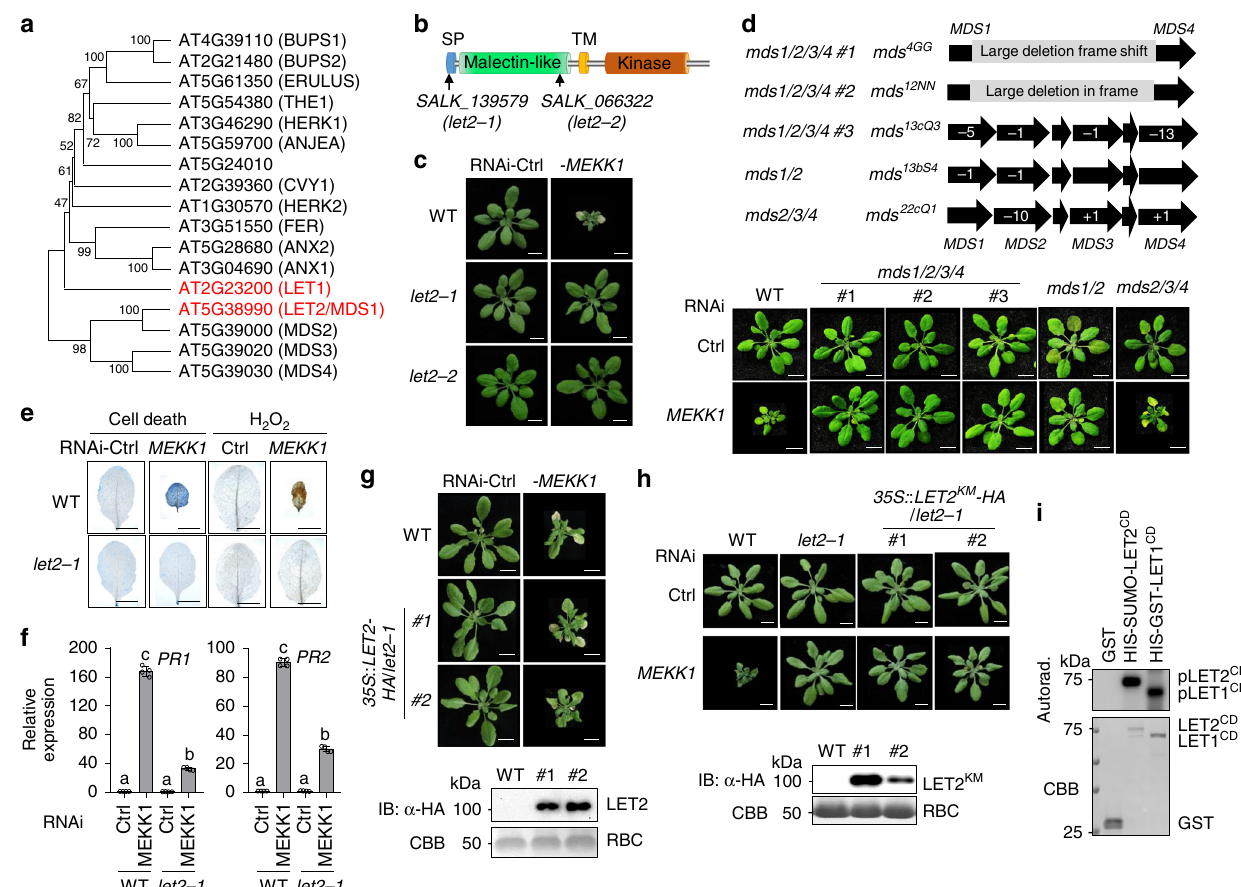
Fig. 1 LET2/MDS1 is involved in RNAi-MEKK1 cell death. a A phylogenetic tree of Cr RLK1L family proteins. The full-length protein sequences were used to generate the phylogenetic tree by the UPGMA method with 1000 bootstrap replicates in MEGA-X. b A schematics depicting LET2/MDS1 protein motifs and T-DNA insertion sites in the let2 mutants. LET2/MDS1 consists of the N-terminal signal peptide (SP), a malectin-like domain, a transmembrane domain (TM), and a cytosolic kinase domain. The arrows indicate the T-DNA insertion sites of the indicated mutant alleles. c The let2 mutants suppress plant dwar fi sm and leaf chlorosis induced by silencing MEKK1 . The plant images were photographed at 3 weeks after inoculation with Agrobacterium carrying the indicated VIGS vectors. Ctrl is the vector containing GFP. Scale bar, 1 cm. d The LET2/MDS1 , but not MDS2 , MDS3 , nor MDS4 ,is involved